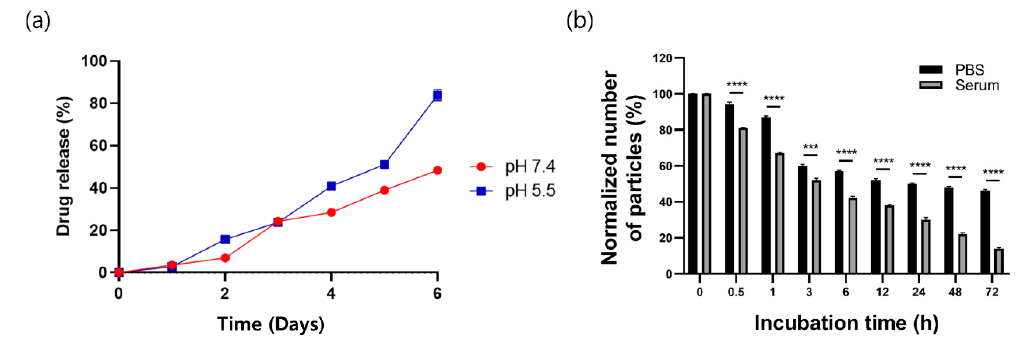
Figure 2. ( a ) Release profile of Cur-PLGA-DPPs in PBS. ( b ) Stability of Cur-PLGA-DPPs in PBS and mouse serum at 37 °C, over different time periods. Values are presented as mean ± standard deviation (asterisks indicate p -values; *** p < 0.005, and **** p < 0.001, compared to data for the 0 h incubation time).